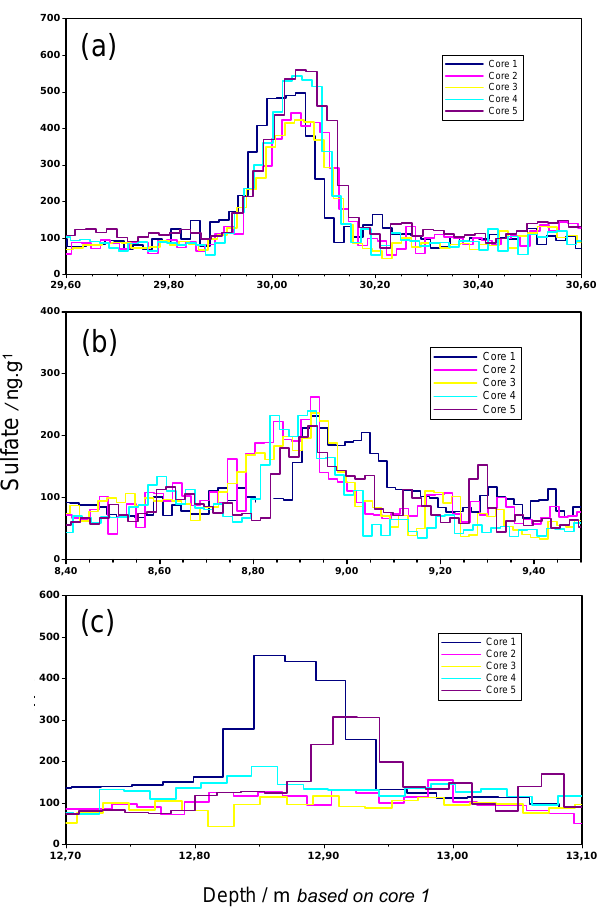
Figure 3. Kuwae ( a ), Krakatua ( b ) and Tambora ( c ) sulfate concen- tration profiles after depth synchronization. All peaks are within a 20cm uncertainty, enabling us to clearly attribute each